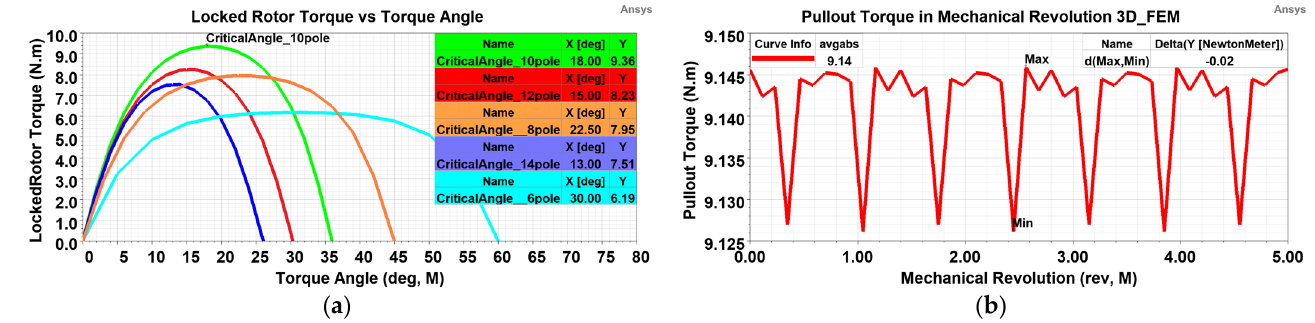
Figure 17. ( a ) Locked-rotor torque versus torque angle; ( b ) Torque ripple in mechanical revolution.